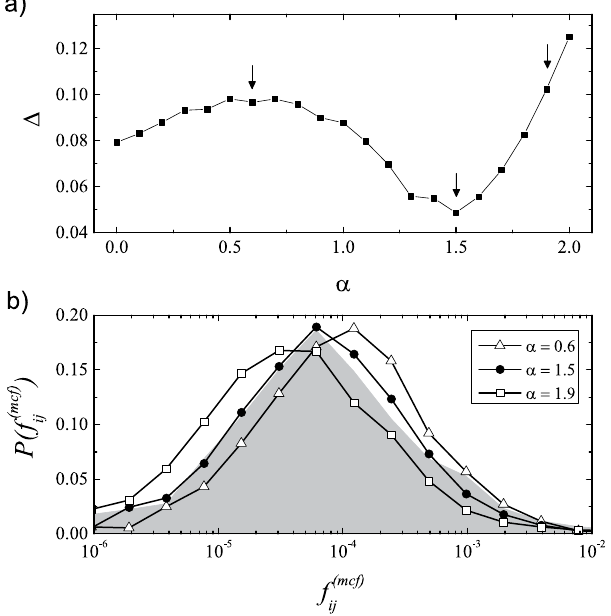
Figure 4. ( a ) Example of the agreement measure Δ ( α ) calculated for different values of parameter α in the year 1996. The arrows show the values for which three histograms P ( f ijmcf )( α ) are shown in panel ( b ). Grey shaded area represents the histogram P ( f ij ) characterizing real data.